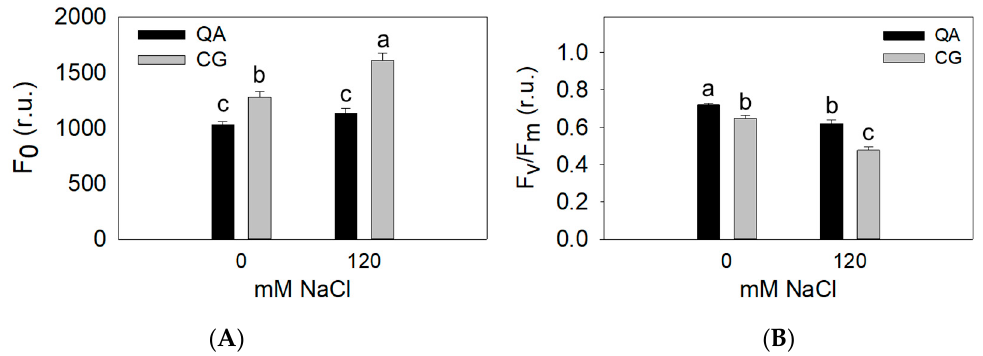
Figure 3. ( A ) Dark-adapted fluorescence emission (F 0 , relative units, r.u.) and ( B ) maximum quantum